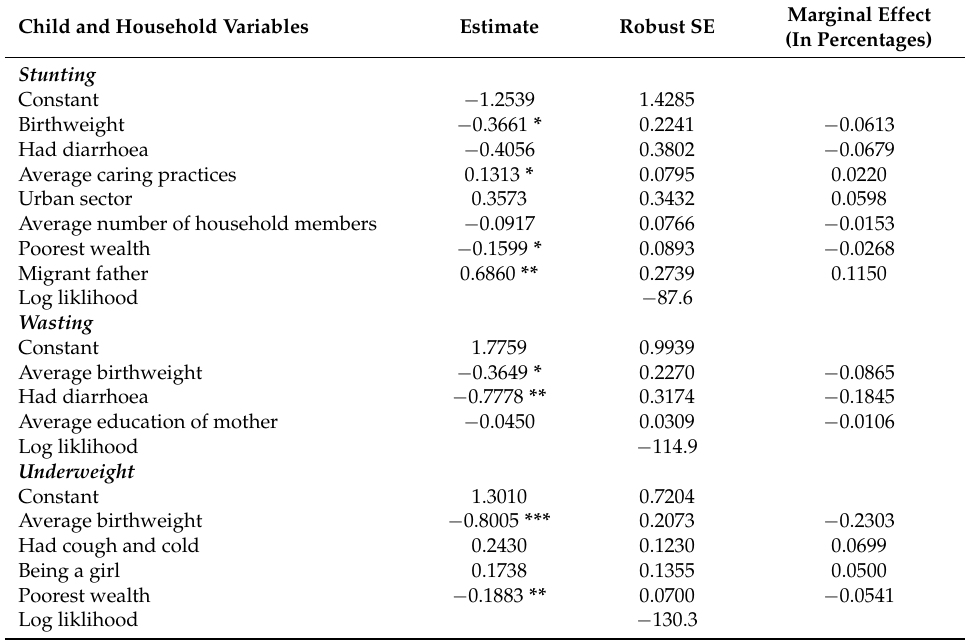
Table 4. Association of child, household variables and care practices by nutritional status—probit model estimation ( n =